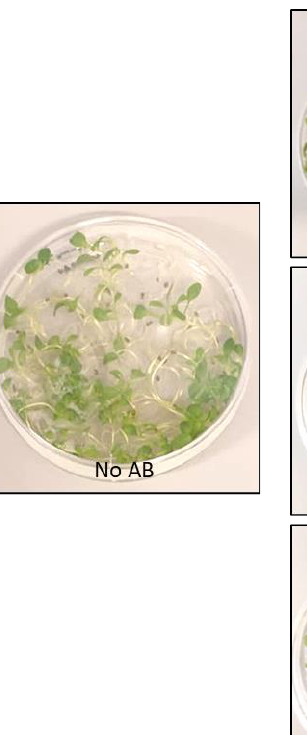
Figure 2. Kanamycin (Kan) and BASTA selection at higher doses. Selection of transgenic Camelina grown in vitro on MS media plates containing variable concentrations of antibiotic. Doses are ex- pressed in mg/L. Picture taken after ( A ) 20 days growth, or ( B ) 30 days growth.